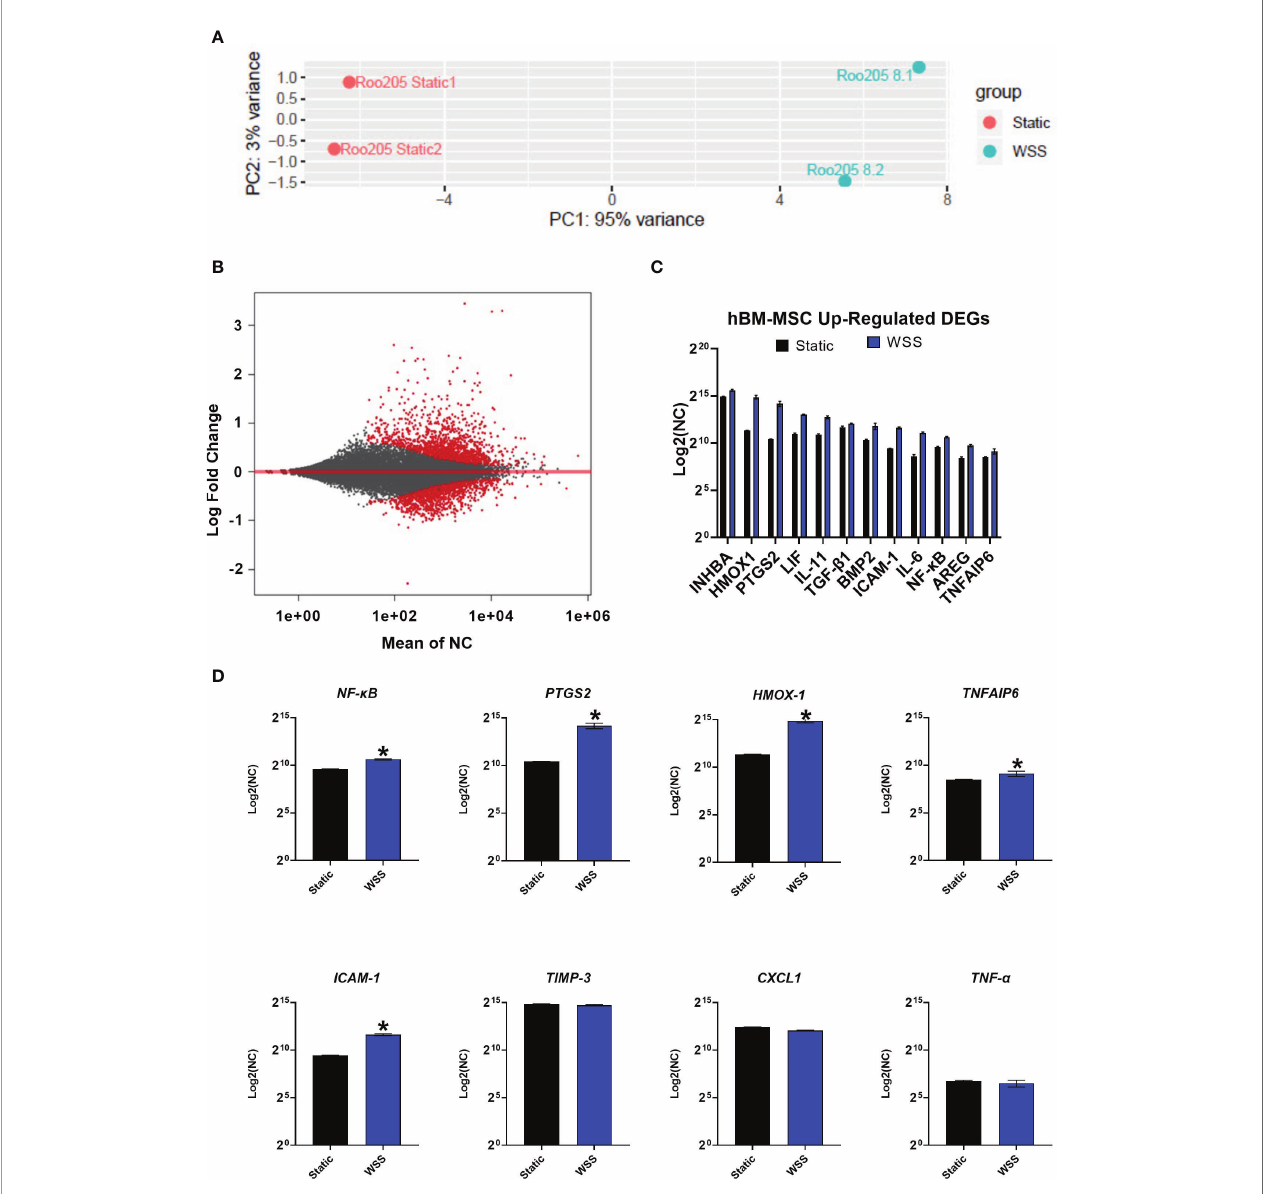
FIGURE 6 | Transcriptome analysis of mechanotransduced hBM-MSC shows enhanced expression of immune mediators. (A) Principal component analysis of conventionally cultured (Static) and 8 dyne/cm 2 conditioned hBM-MSC (WSS) (n=2). Samples are plotted by variance across the two primary principal components (PC1, PC2). (B) MA Plot depicting distribution of differentially expressed genes (DEG, in red) plotted by the mean normalized count (NC) against the log fold change. (C) A curated list of WSS-induced, up-regulated differentially expressed genes. Y-axis depicts NC by DESeq2 (n=2). (D) Expression of established in fl ammatory mediators. Y-axis depicts NC (n=2, *p-adj<0.05). INHBA , Inhibin Subunit Beta A; HMOX1 , Heme oxygenase 1; PTGS2 , Prostaglandin-Endoperoxide Synthase 2; LIF , Leukemia Inhibitory Factor; IL-11 , Interleukin 11; TGF- b 1 , Transforming Growth Factor Beta 1; BMP2 , Bone Morphogenetic Protein 2; ICAM-1 , Intracellular